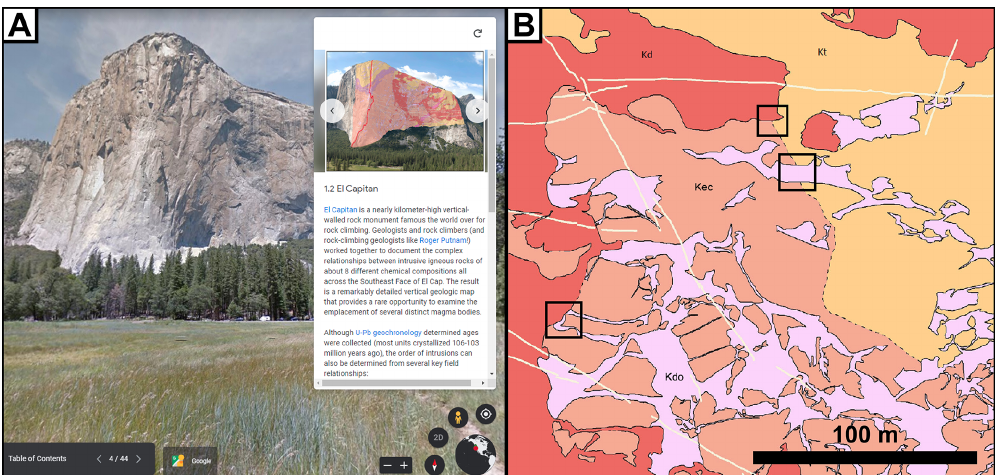
Figure 4. Introducing a complex relative dating exercise. (a) A stop on the geology of Yosemite Valley VFT (© Google Earth Web) high- lighting the vertical geologic map of El Capitan, created by Putnam et al. (2014), and providing an overview of the knowledge (cross-cutting relationships, law of included fragments, and gradational contacts) necessary to relatively date the intrusive units. (b) An excerpt from the modified Putnam et al. (2014) El Capitan geologic map that students use to determine the relative timing of eight intrusive units. Black boxes highlight three areas that provide unambiguous relationships between two or more